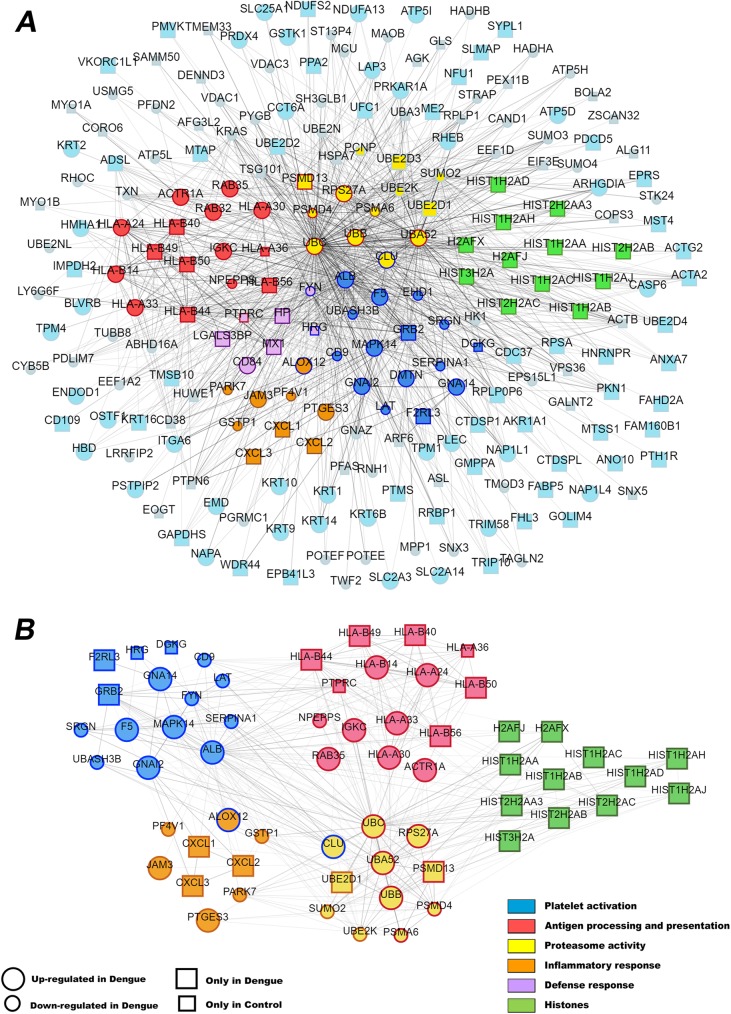
Interaction network of proteins differentially expressed between dengue and control platelets.(A) List of all 905 interactions between 252 differentially abundant proteins detected by the proteomic analysis. (B) A GO analysis validated the following biological processes: “platelet activation”, “antigen processing and presentation”, “proteasome activity”, “inflammatory response” and “histones”. Proteins labeled with two colors (fill and boundary colors) are involved in two biological processes. Larger circles represent proteins upregulated in dengue. Small circles indicate proteins downregulated in dengue. Squares represent proteins detected only dengue (large) or control (small) conditions.